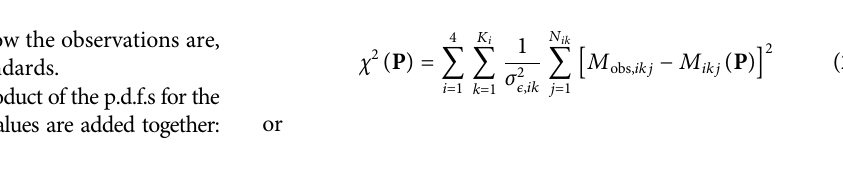
Frontiers in Astronomy and Space Sciences |